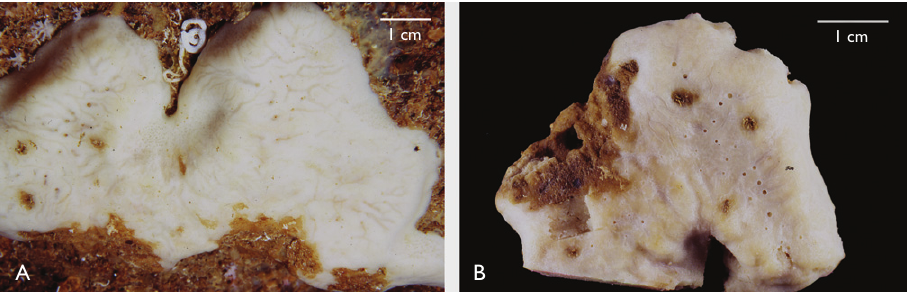
Fig. 1. Habitus of the cave-dwelling Mediterranean Neophrissospongia nana nov. sp. from north-west- ern Sardinia. A. In situ plate-like growth form in the type locality Grotta delle Terrazze (photo by R. Barbieri), B. Holotype MSNG 54599 (top view) (photo by G. Delitala).